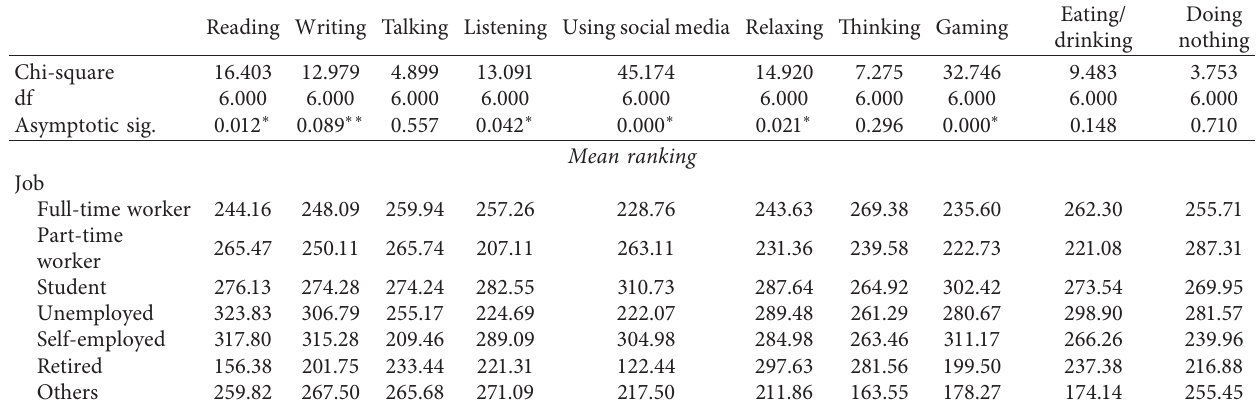
Table 16: Kruskal–Wallis test statistics and the rankings of job groups.